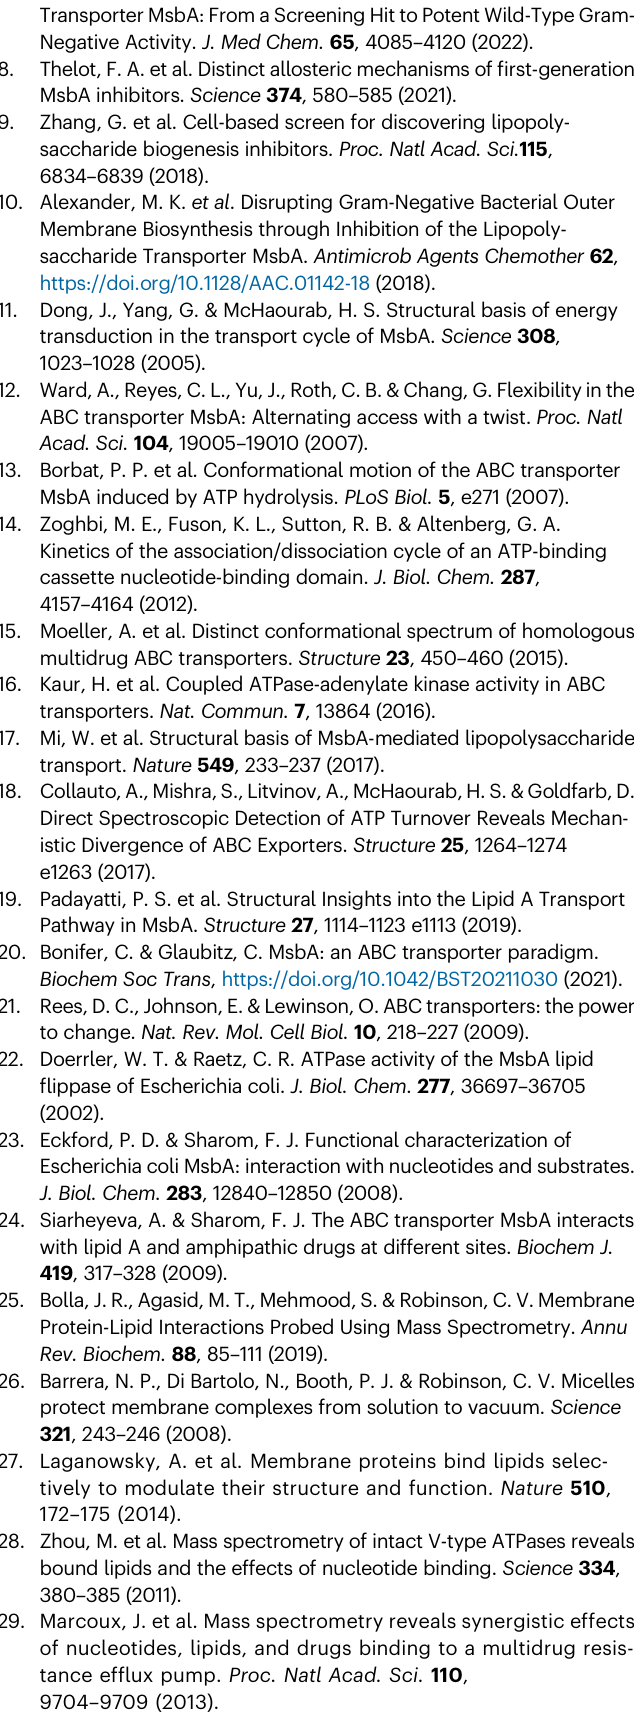
Supplementary Table 9 for the details of model